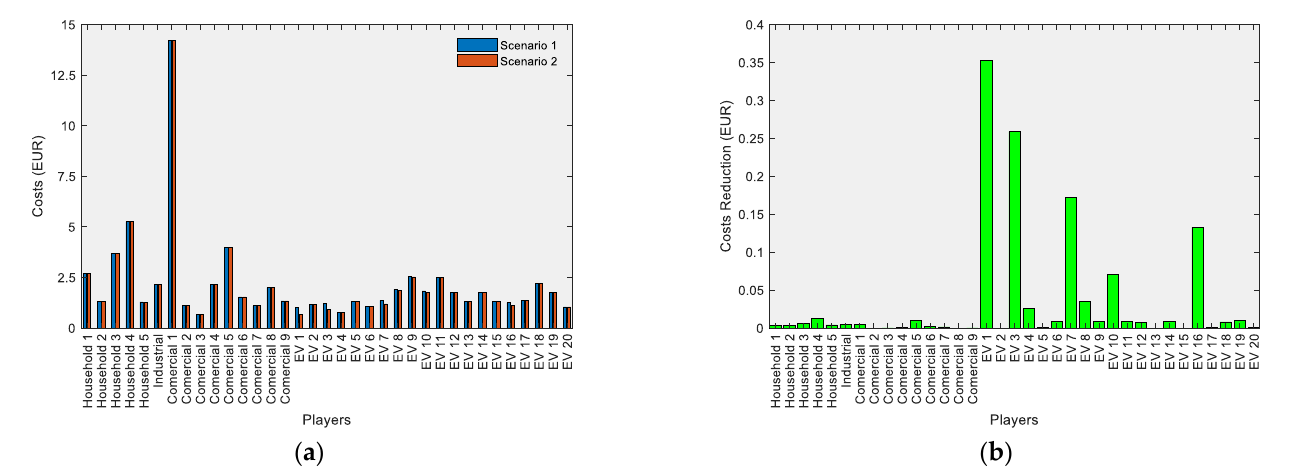
Figure 4. ( a ) Operational costs for one day of operation and ( b ) reduction on operational costs.